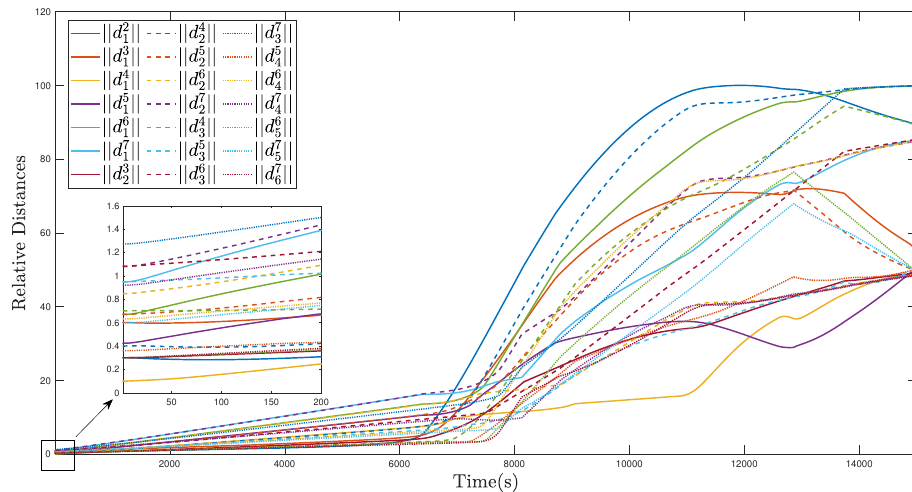
Figure 6. Relative distances of the MSAs system in the region coverage process.